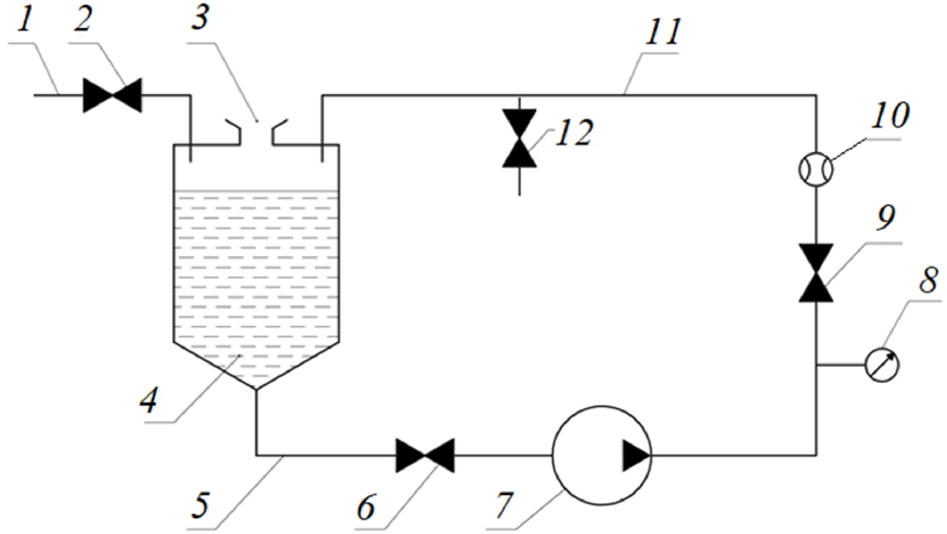
Figure 4. Test hydraulic diagram of the bench for testing the operating stages of electric centrifugal pumps. Water with mechanical impurities with a concentration of C = 3 g/L was used as a